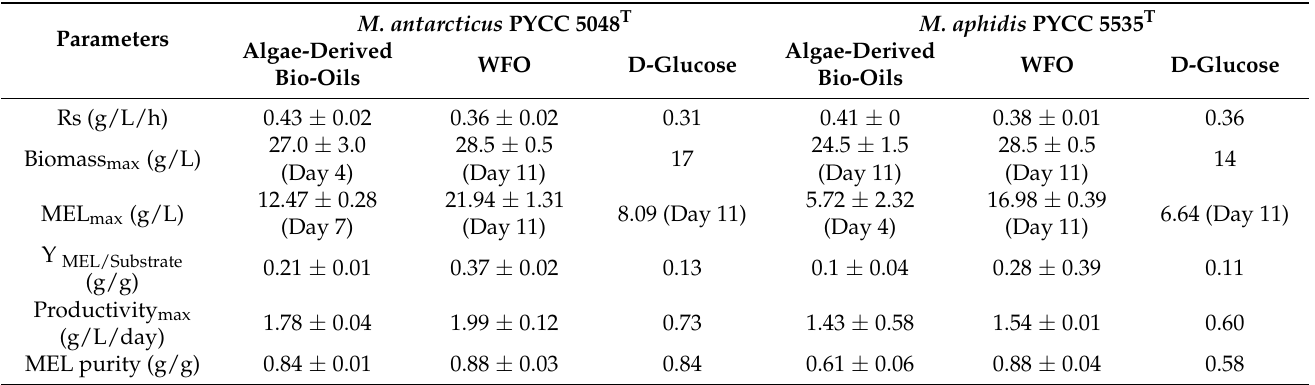
Table 2. Rate of D-glucose consumption (Rs); maximum biomass produced; Maximum MEL yield obtained (g/L); yield of MELs produced (gMELs/gSubstrate), maximum productivity (g/L/h) and purity (g/g) for M. antarcticus PYCC 5048T and M. aphidis PYCC 5535T using 40 g/L of D-glucose with 20 g/L of hydrophobic carbon source (algae-derived bio-oils or waste frying